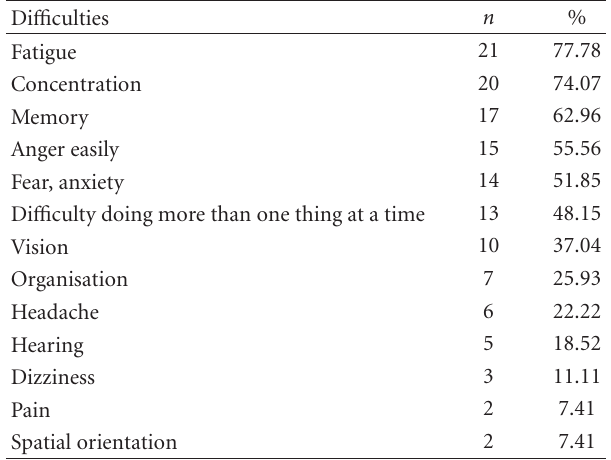
Table 2: Di ffi culties mentioned by the participants that have an impact on overall everyday